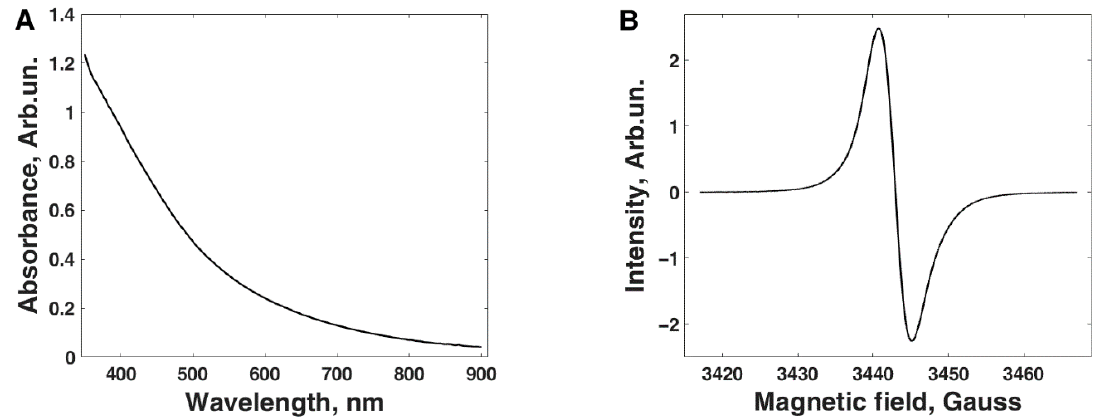
Figure 4. ( A ) An example UV-Vis absorbance spectrum obtained for the melanin sample. The curve shows a simple decaying exponential as expected for the material. ( B ) An example CW-EPR X-band spectrum obtained for the sample.